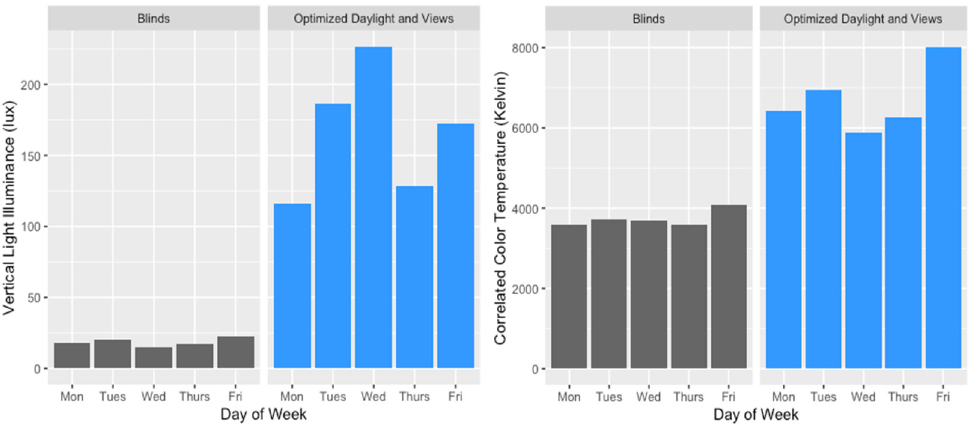
Figure 3. Comparison of daily exposure to vertical light illuminance and correlated color temperature (CCT) across the study conditions.